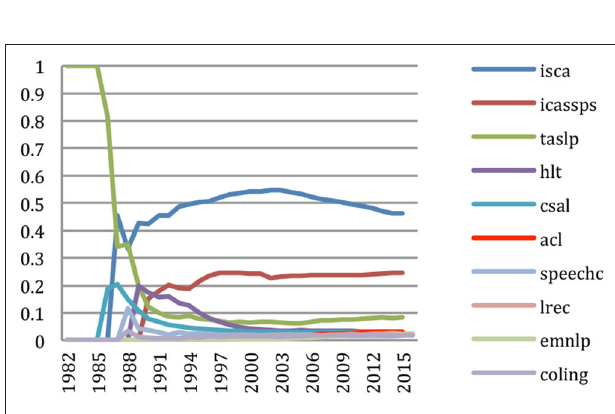
FIGURE 19 | Sources’ contributions to the study of HMM (% of topical